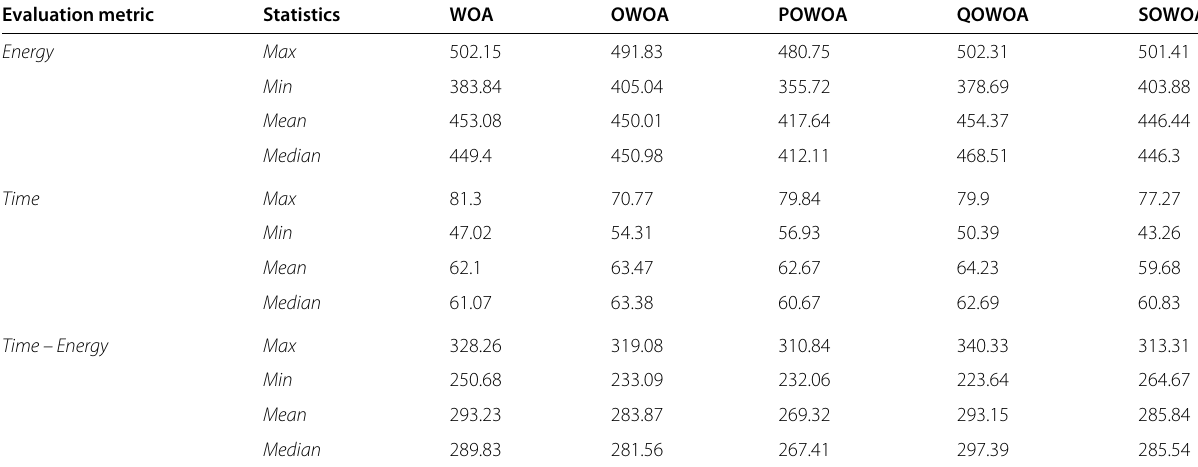
Table 9 Results of 4 OBL techniques on all evaluation metrics on WOA Evaluation metric